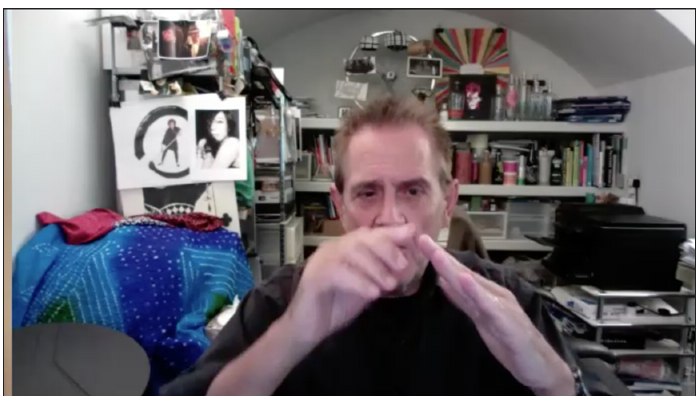
Figure 3: Dave illustrates a triangle with his hands showing the